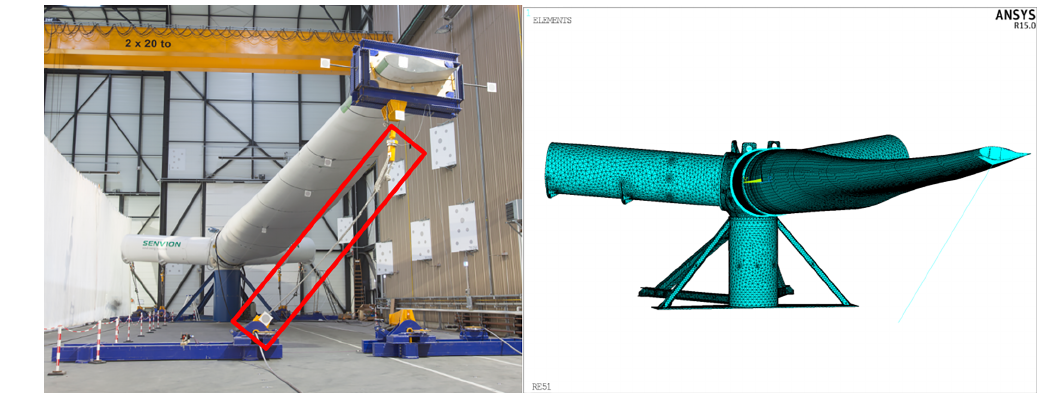
Figure 1. Pitch-bearing test rig at Fraunhofer IWES and corresponding FE model.